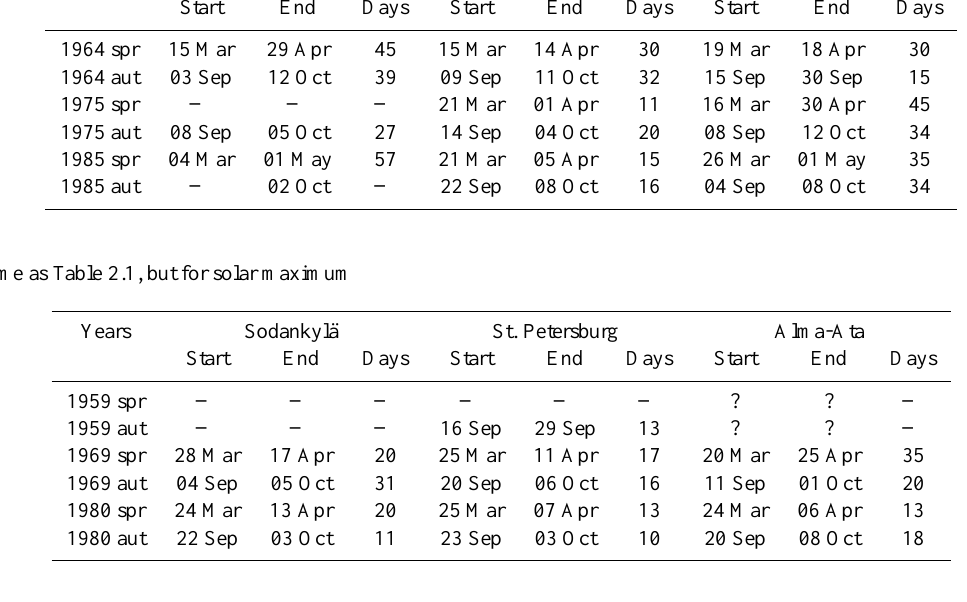
Table 2.1. Start and end dates of the equinoctial transitions for the latitudinal chain of stations during solar minimum. Dashes indicate missing or poor observations Years